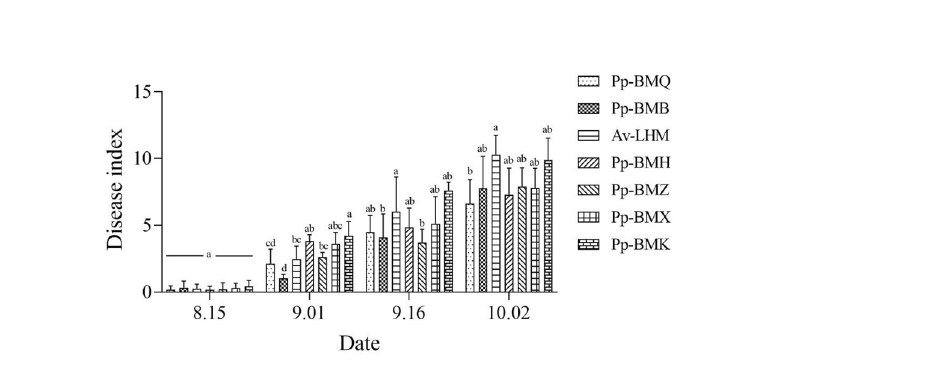
Figure 8. The disease index of seven ecotypes stem necrosis lesions disease caused by B. exigua var. rhapontica in 2021 in the